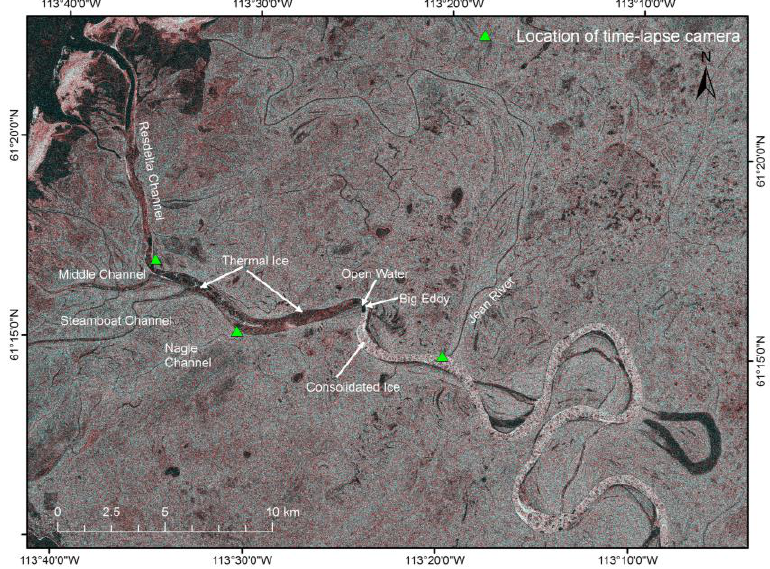
Figure 3. Example of ice cover types identified visually on sigma-nought RADARSAT-2 imagery (FOW3 beam mode), acquired on 21 November 2013. The HH, HV, and HV polarizations were assigned the colors red, green, and blue, respectively, for the image display. (RADARSAT-2 Data and Products © MacDonald, Dettwiler and Associates Ltd. (2013)—All Rights Reserved. RADARSAT is an official trademark of the Canadian Space